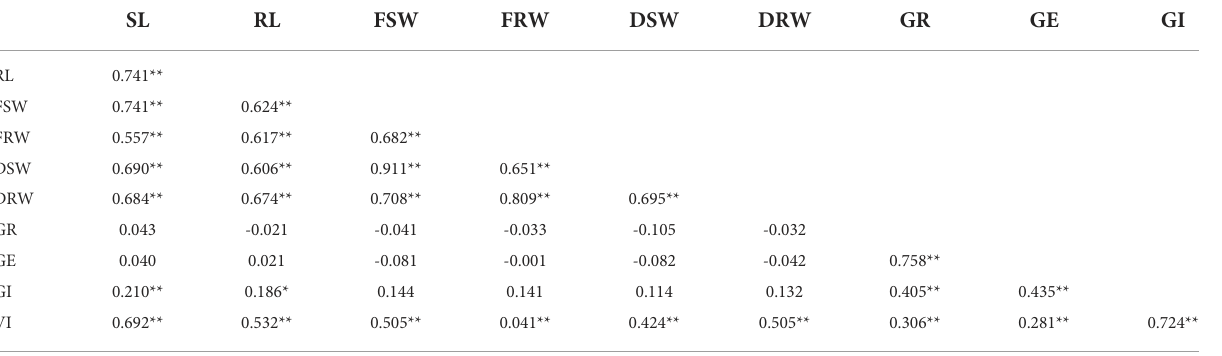
TABLE 2 Correlations among seed vigor related traits in the Yangmai 16/Zhongmai 895 DH population.